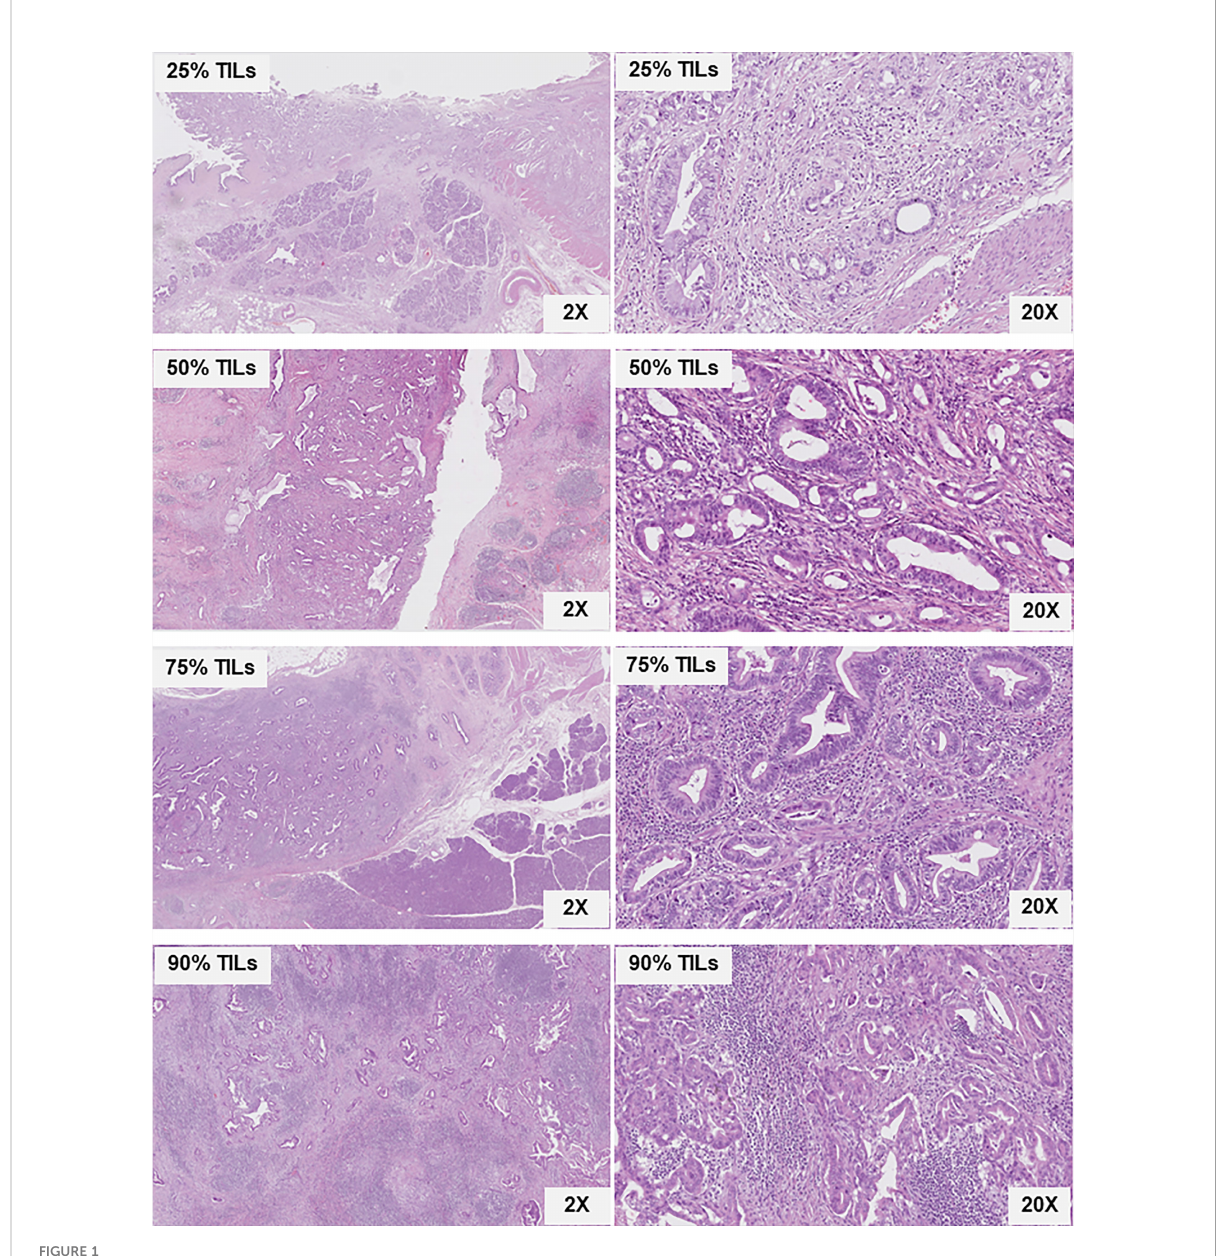
FIGURE 1 Histological sections of various distal cholangiocarcinoma stained with H&E showing tumor glands, stroma, and TILs. The percentage rates of TILs distribution in the stroma and tumor areas comprising 25%, 50%, 75%, and 90%, according to the ITWG guideline, are shown at ×2 and ×20 magni fi